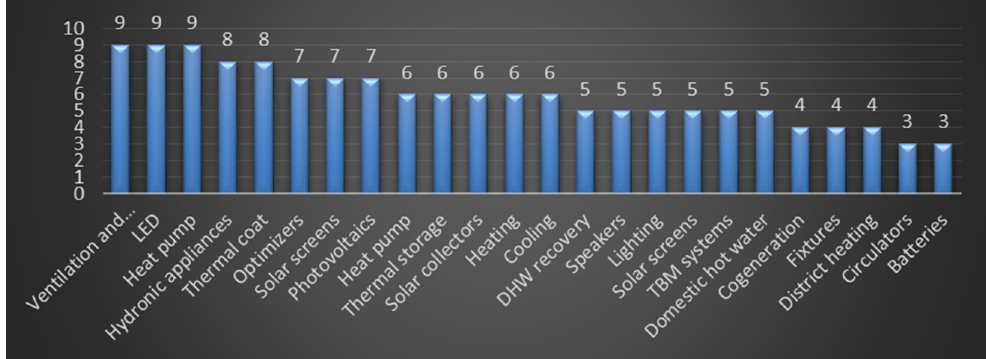
Figure 1. Classification of the Table X in residential sector: the histograms show the classes of EEMs in terms of numerical values (descending